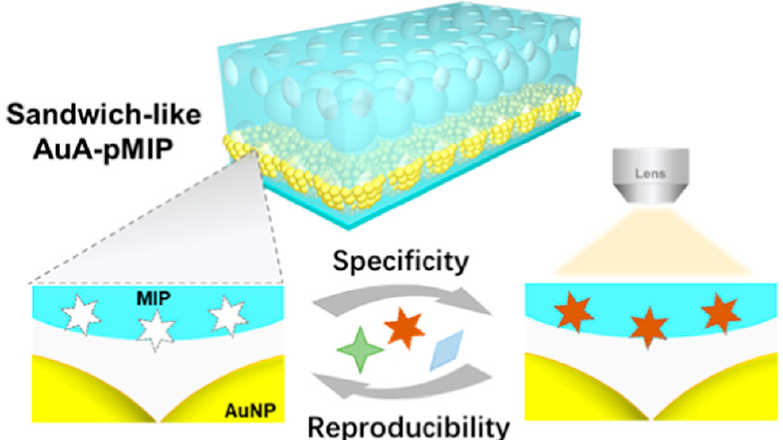
Figure 7. Working principle of the sandwich-like AuA-pMIP sensor. Reprinted with permission from reference [53]. Copyright 2020 American Chemical Society (Washington, DC, USA).